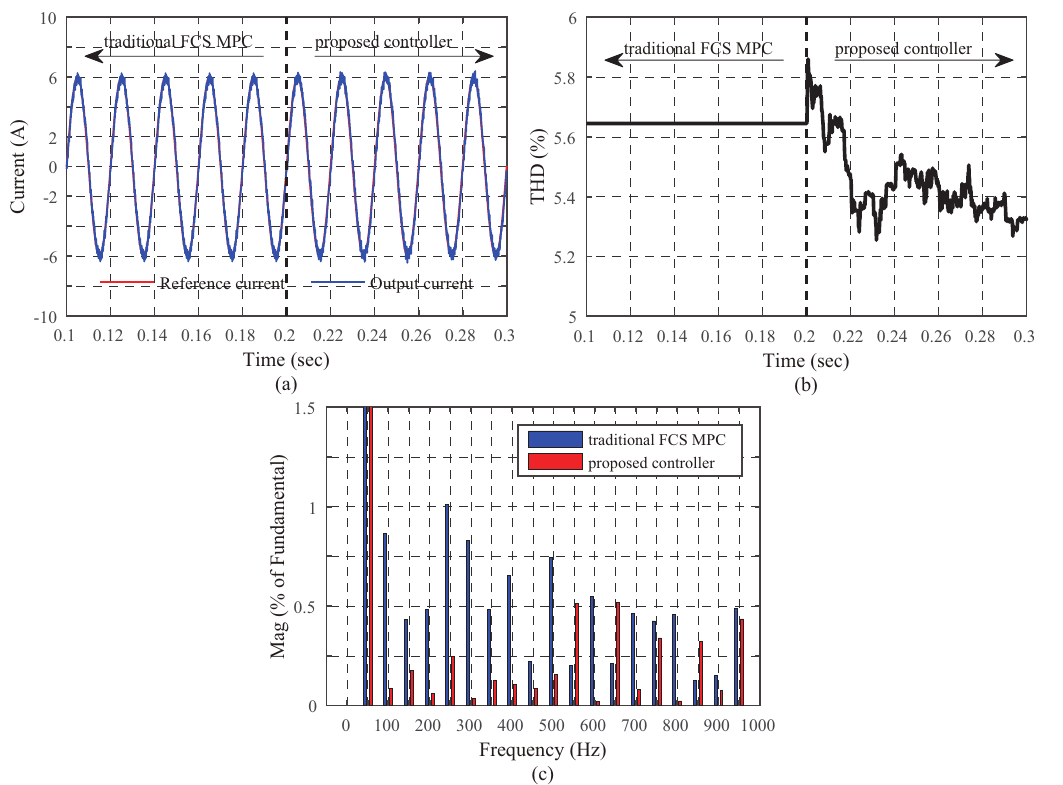
Figure 7. Simulation results of two methods: ( a ) output current; ( b ) THD; and ( c ) harmonic analysis.